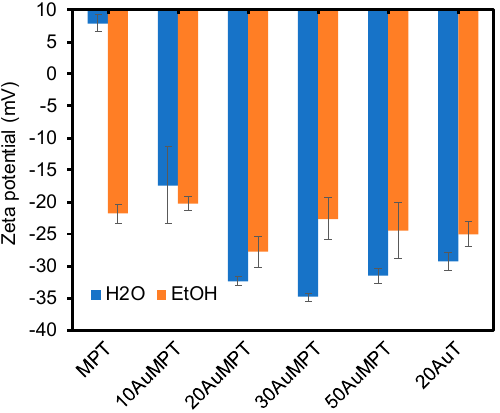
Figure 4. Zeta potentials of bare MPT (mesoporous TiO 2 ) and various AuNP-loaded MPT composite particles in water and EtOH. (Note: AuT, AuNPs onto nonporous TiO 2 particles).